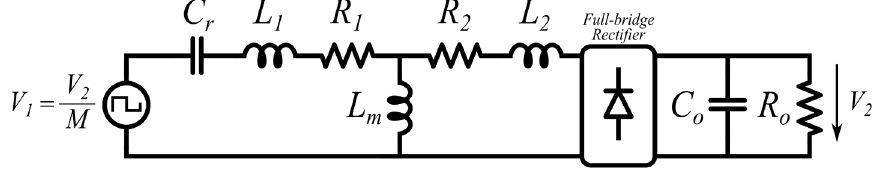
Figure 11. TB LLC circuit with distributed inductances and resistances.